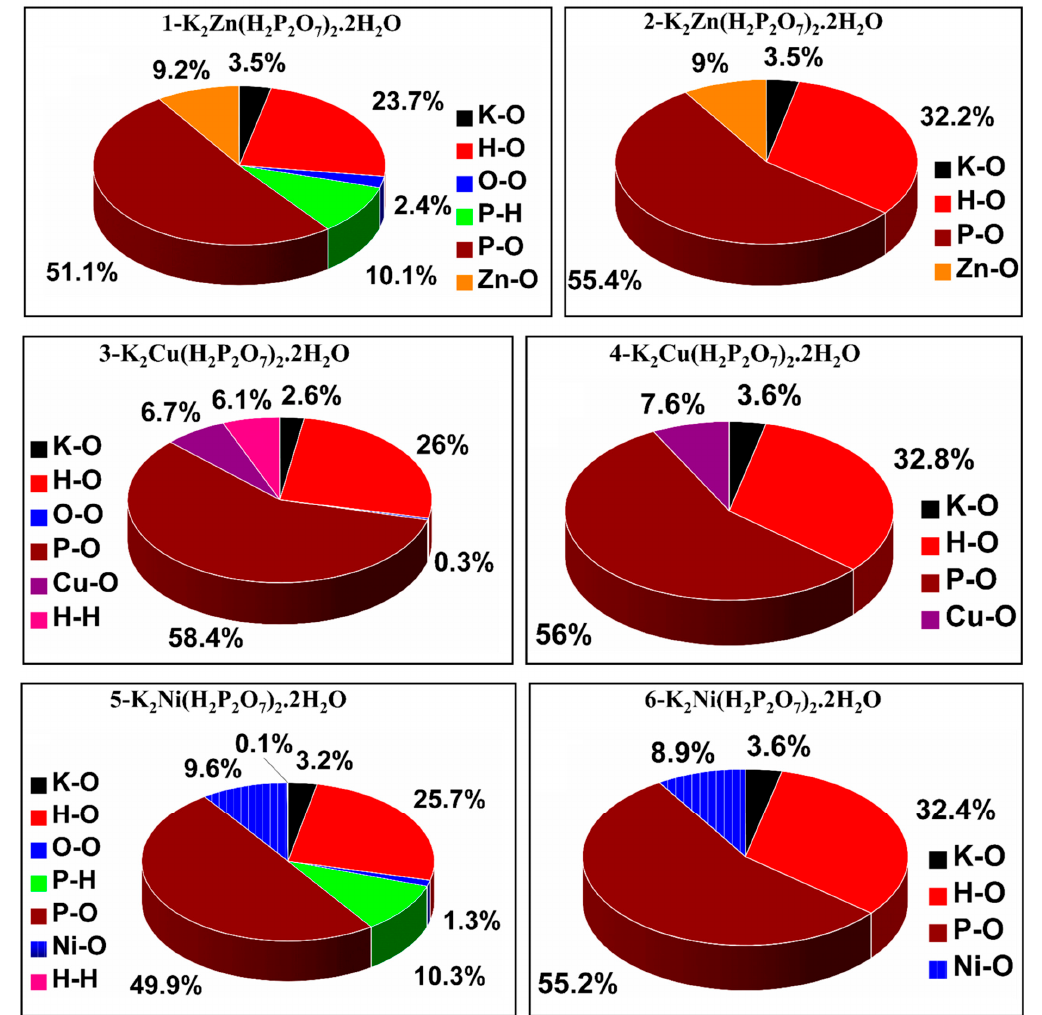
Crystals 2022 , 12 , x FOR PEER REVIEW Figure 4. The pie charts show the percentages of different bonding types for crystals from 1 to 6.